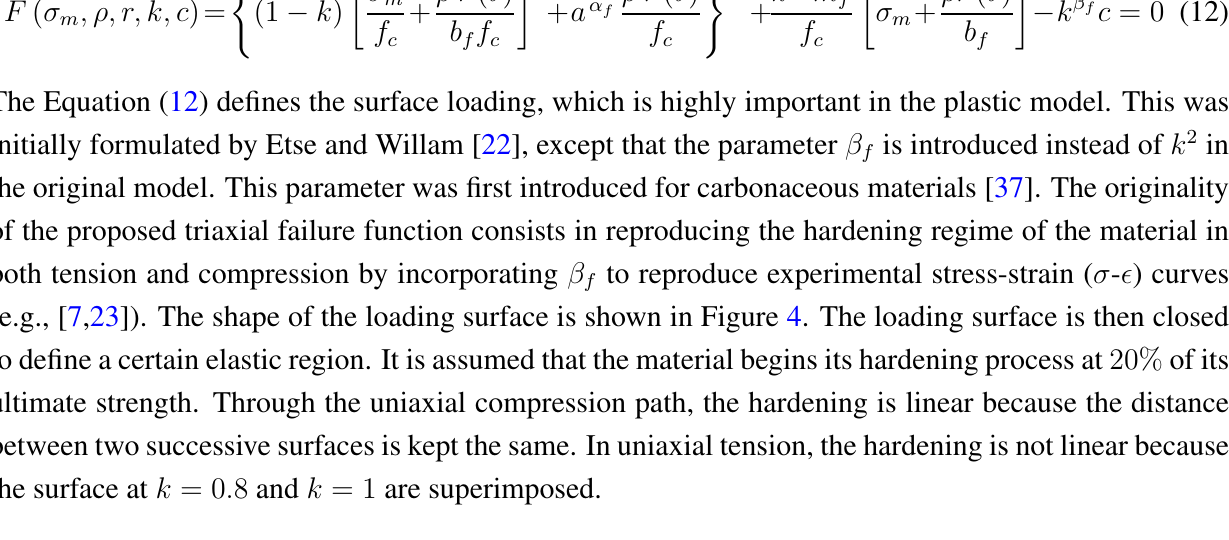
Figure 4. Triaxial failure envelope in hardening